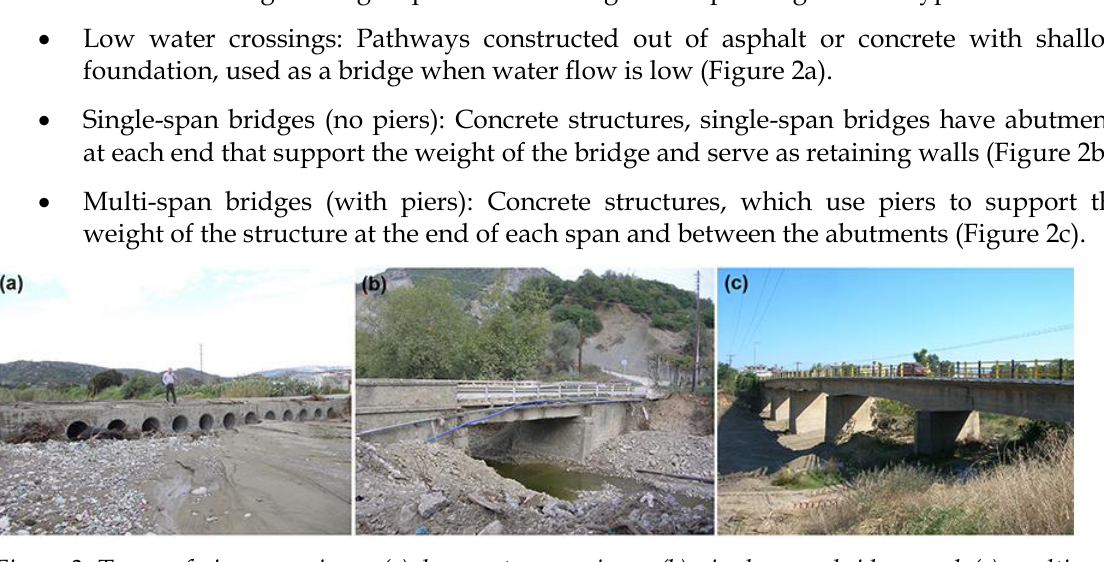
Figure 2. Types of river crossings: (a) low water crossings, (b) single-span bridges and (c) multi-span